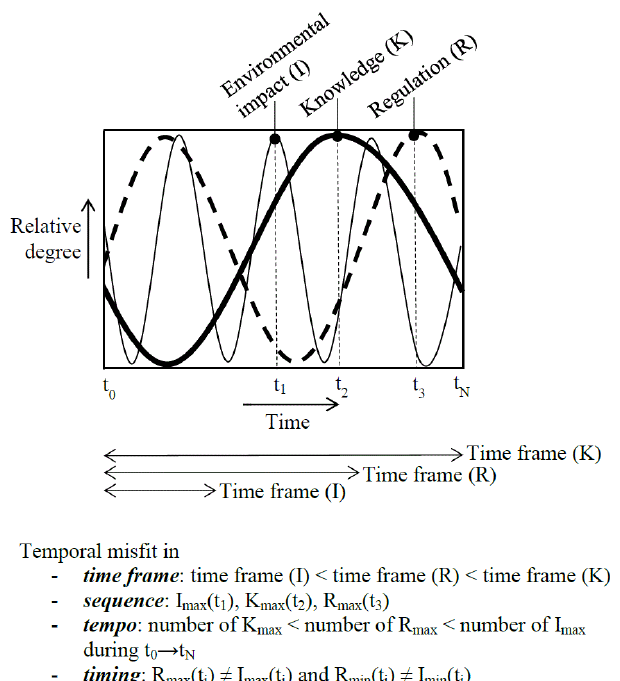
Fig. 1 . Temporal misfit in time frame (the time frame of regulation is longer than that of the adverse impact of chemicals), sequence (scientific knowledge of adverse impacts must precede regulatory action), tempo (the rate of knowledge production on adverse impacts is slower than the rate of emergence of complex new impacts), and timing (the cycles of regulation and impacts do not match). Knowledge, regulation, and impact are mutually dependent variables, and variation in the degree of knowledge, regulation, and impact is relative. A low point in the degree of knowledge, for example, does not mean there is no accumulation of knowledge over time, it only refers to a temporary knowledge deficit in relation to environmental impacts and regulatory